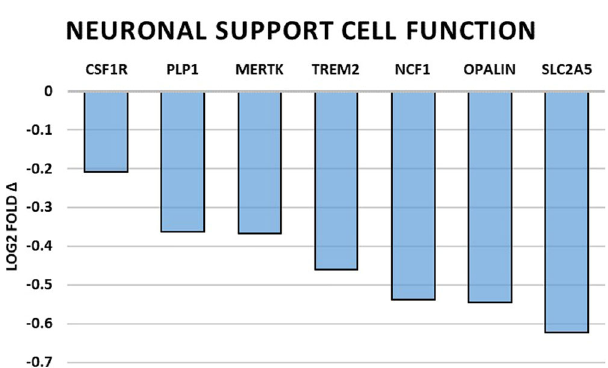
Fig. 2 Space fl ight-induced changes of gene expression related to neuronal support cell function. Bar graph summarizing log2 fold- changes of signi fi cantly differentially expressed genes (DEG) ( p < 0.05) in the fl ight (FLT) group compared to the ground control (GC) group in genes directly related to neuronal supporting cell function. N = 6/group. P values are calculated using one-way analysis of variance (ANOVA) and Tukey ’ s HSD (honestly signi fi cant difference) test. Source data are provided as a Source Data fi